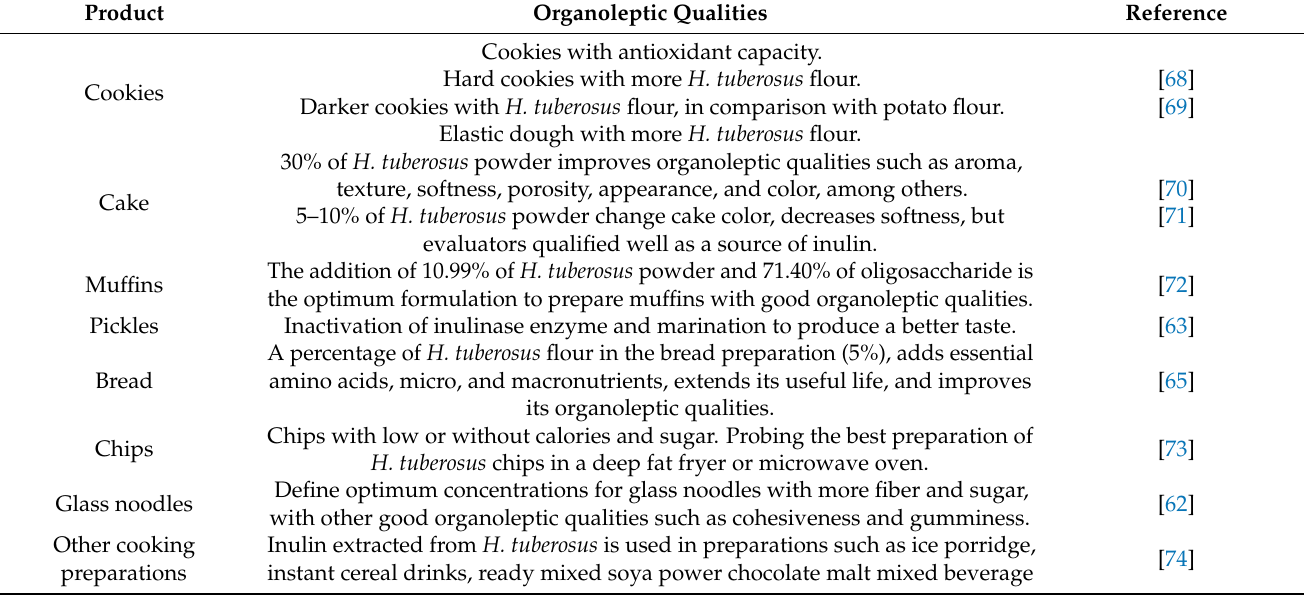
Table 3. Summary of cooking products with H. tuberosus